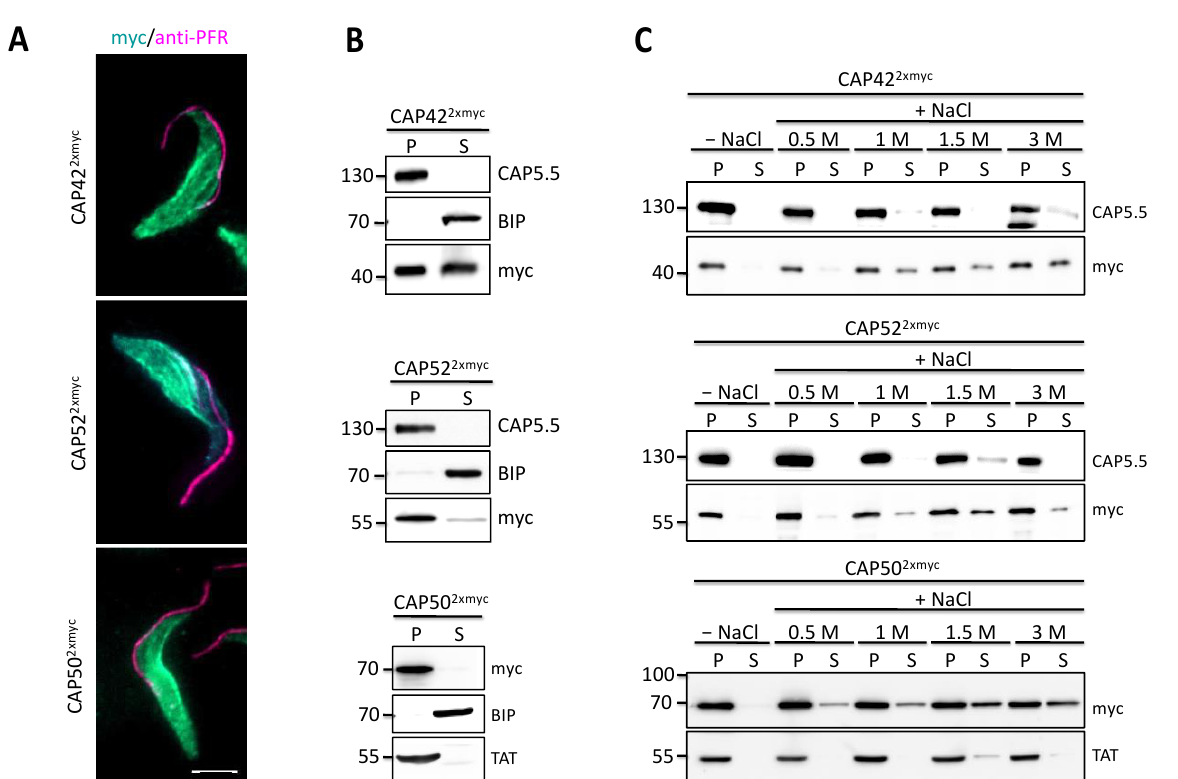
Figure 2. Characterisation of three cytoskeleton associated proteins. ( A ) Dox-inducible ectopic expression of C-terminally myc-tagged CAP42, CAP52 and CAP50 in T. brucei . The localisation of the CAPs to the cytoskeleton but excluding the flagellum was analysed by labelling 1% NP40 treated cells with anti-myc (green) and anti-PFR antibody (L13D6, magenta) to mark the flagellum. Scale bar = 5 µ m ( B ) Dox-induced cells were fractionated with 1% NP40 and the soluble (S) and pellet (P) fractions were analysed for the myc-tagged proteins. Fractions corresponding to equal cell numbers were loaded in all lanes ( C ) The cytoskeleton-containing pellet fractions from C were treated with increasing amounts of NaCl and the supernatants (S) and pellets (P) were analysed for the myc-tagged proteins. Tubulin (TAT), CAP5.5 and BIP served as the loading control for the insoluble and soluble fraction, respectively. Representative blots of three biological replicate experiments are shown.